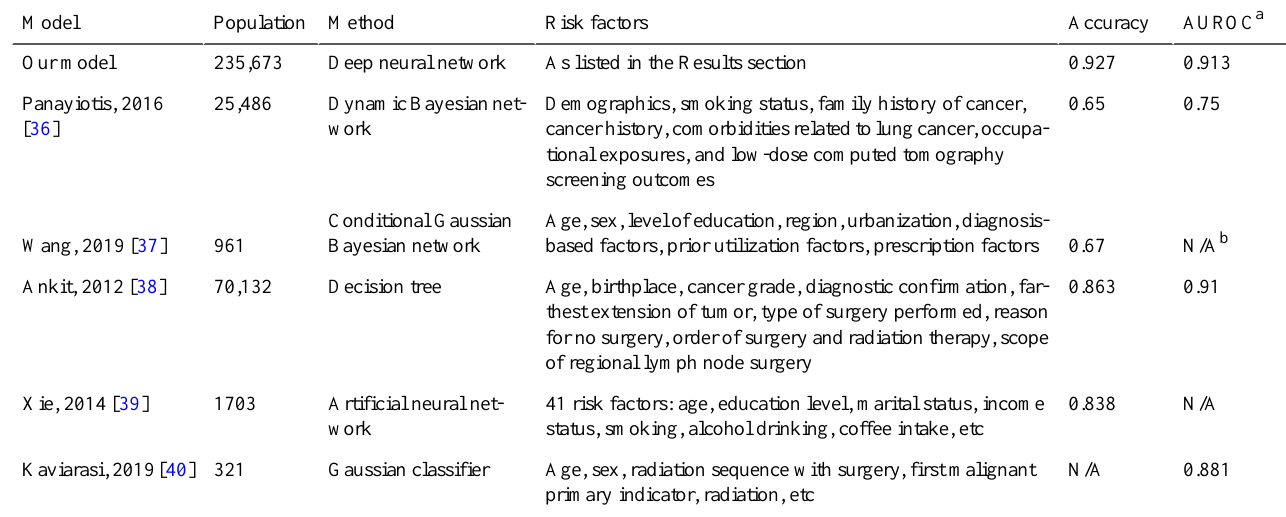
Table 4. Comparison of our model with previous models for identifying lung cancer risk factors.